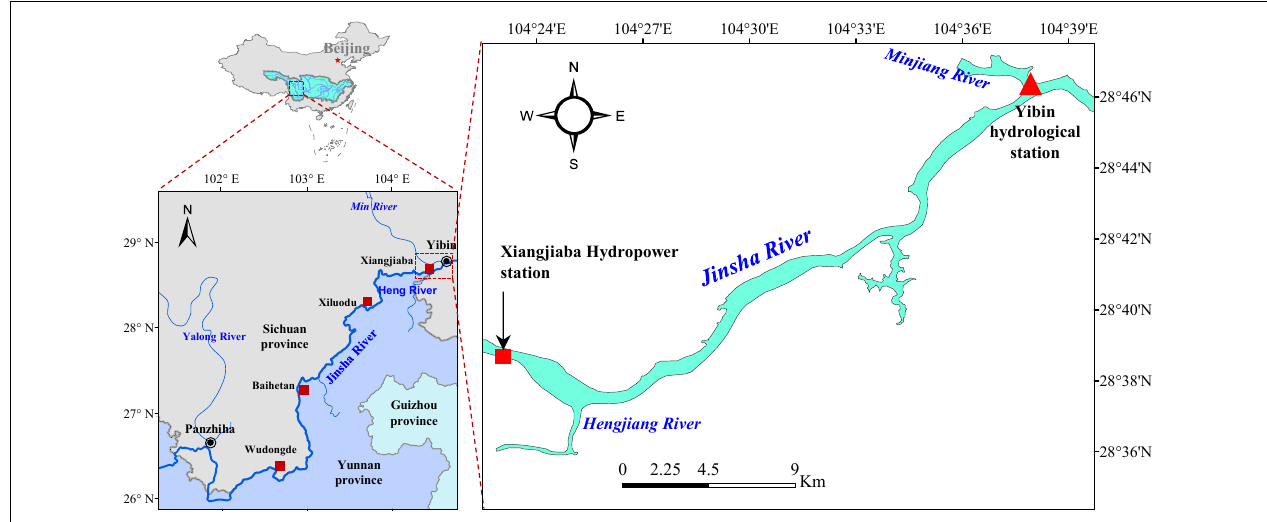
FIGURE 1 | Locations of cascade hydropower stations in the lower reaches of the Jinsha